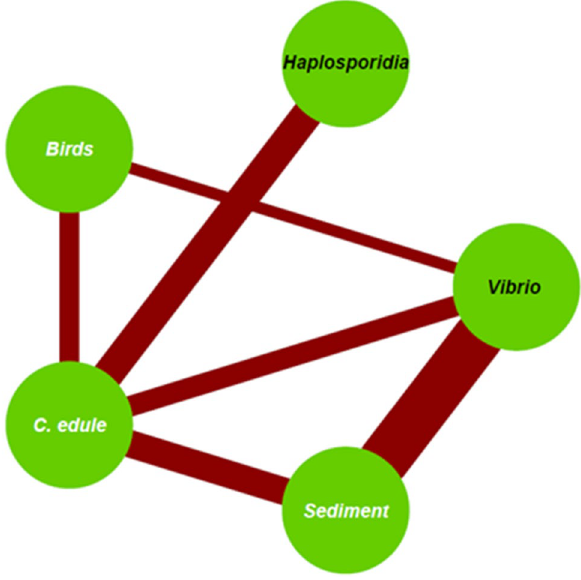
Figure 1. Network association plot displaying the links between the different compartments studied. The black text refers to pathogens and the white text relates to hosts/reservoirs. A solid line represents target DNA presence and line thickness indicates the prevalence (%) of infected C. edule and the percentage of positive faecal and sediment